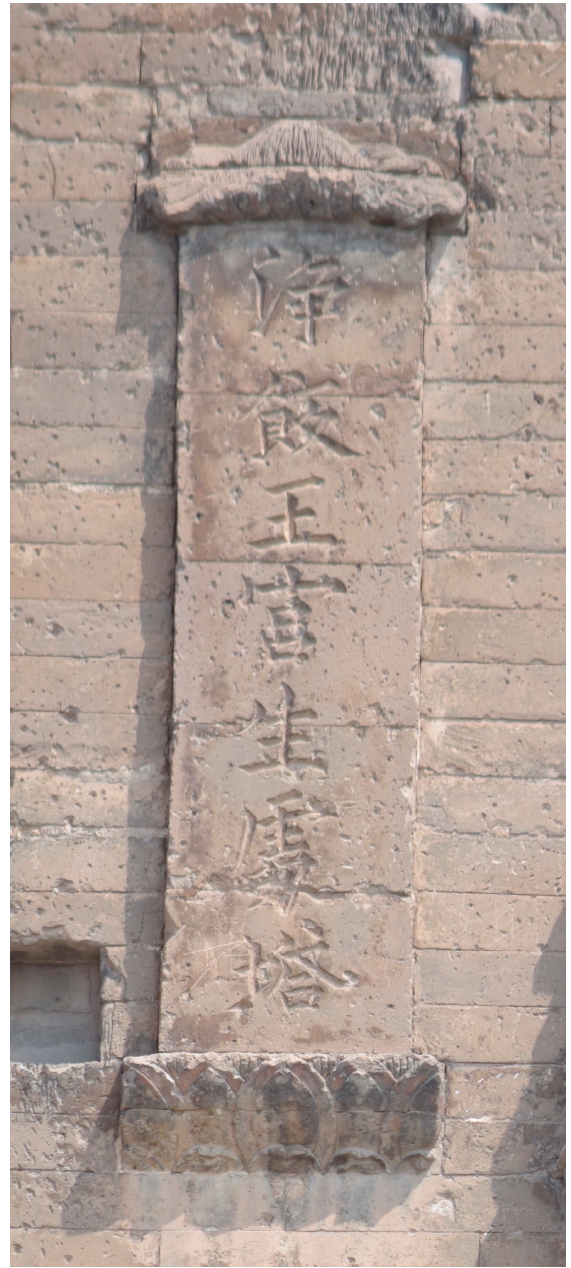
Figure 12. Cartouche of miniature pagoda, east side of the south wall of Chaoyang North Pagoda. Liao dynast, 1043–1044. Chaoyang, Liaoning Province, China [©Photograph by Youn-mi Kim, 2014].